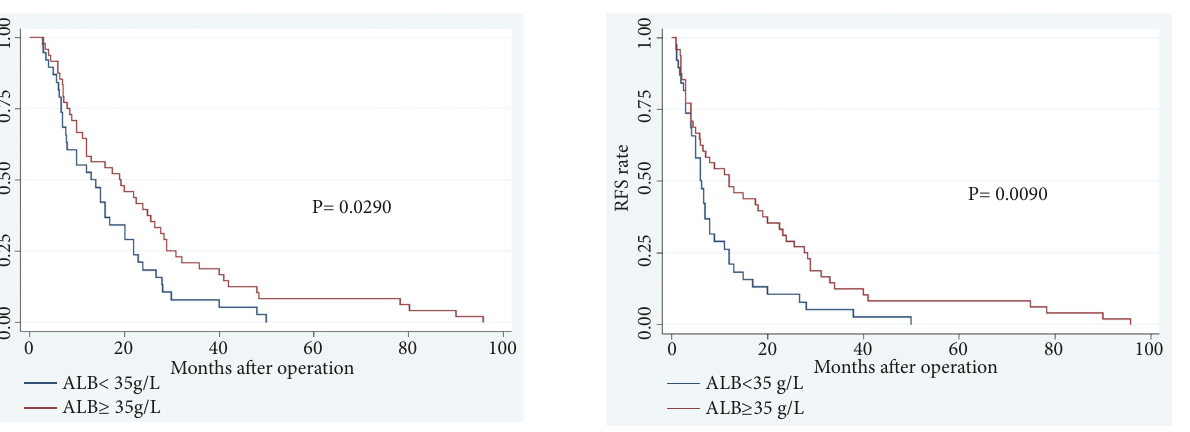
Figure 4: Recurrence-free survival in patients with cholangiocar- cinoma according to ALB levels (P=0.0090) (ALB, albumin; RFS, recurrence-free